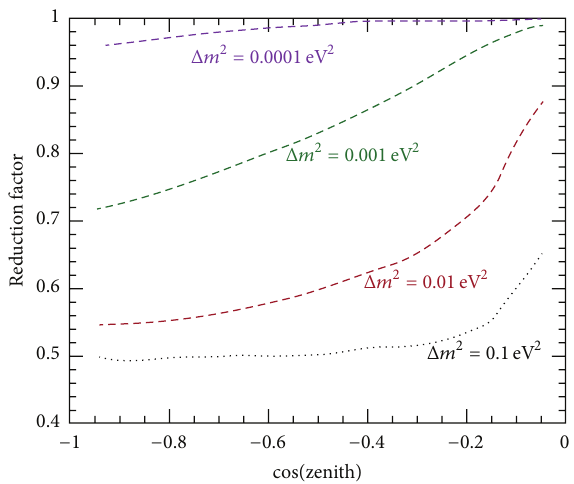
Figure 4: Reduction factor in the number of upgoing muons for different Δ𝑚 2 23 values for a muon detection threshold of 1GeV (MC studies). Note the shape dependence vs the Δ𝑚 2 23